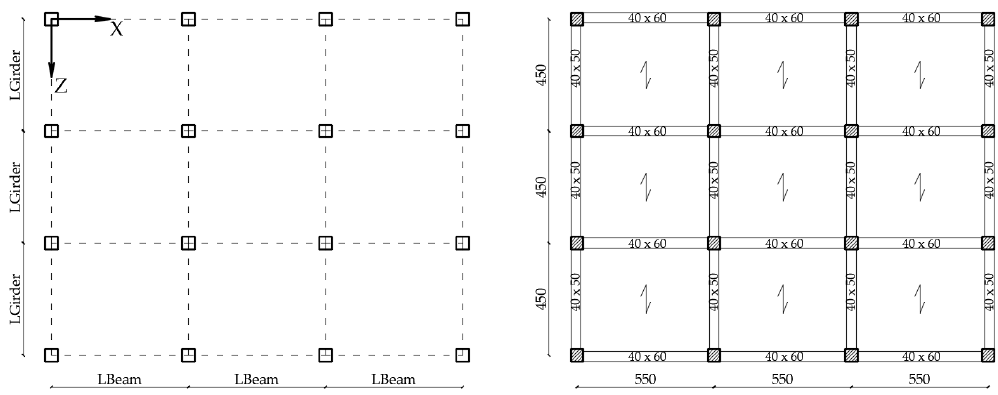
Figure 2. Standard floor plan. Dimensions are in centimeters.